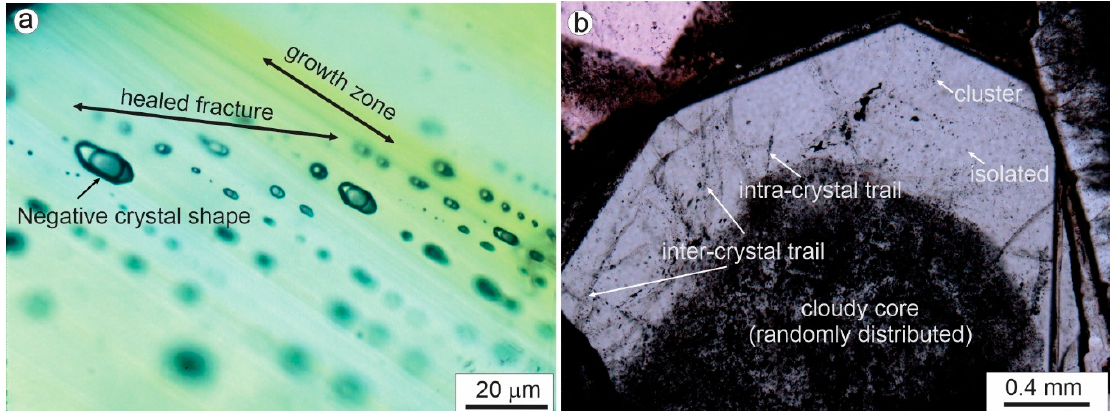
Figure 2. ( a ) Secondary fluid inclusions with negative crystal shape in a healed fracture (shown by distribution of fluid inclusions on the same focus plane) crosscutting growth zones (shown by color variation) in a cassiterite crystal; the sample is from the Dongjia’ao Sn deposit, Guangxi, China. ( b ) Various modes of occurrences of fluid inclusions in a quartz crystal, including randomly (and densely) distributed inclusions in the cloudy core overgrown by a relatively clean rim, with fluid inclusions occurring in clusters, intra-crystal trails, inter-crystal trails and as isolated ones in the rim; note the fluid inclusions are not simply labeled as primary, pseudosecondary or secondary, as discussed in the text; the sample is from the Beaverlodge uranium district, Saskatchewan, Canada.